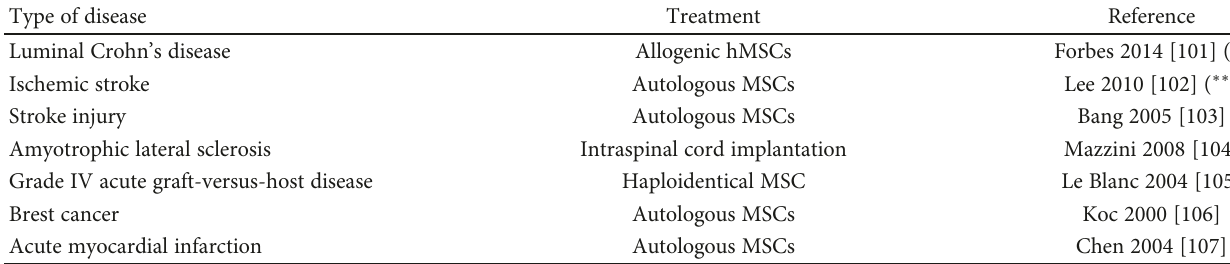
Table 1: Successful clinical trials involving hMSC expanded in vitro with FBS-containing medium.